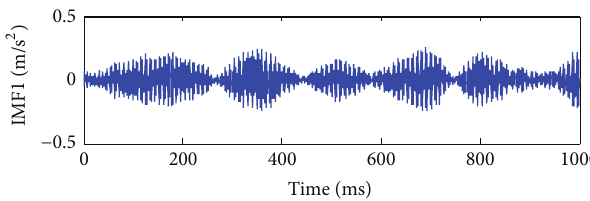
Figure 6: Extracted useful signal from 5dB IMF1 based on combi- nation of “3 𝜎 ” criterion and SVD.